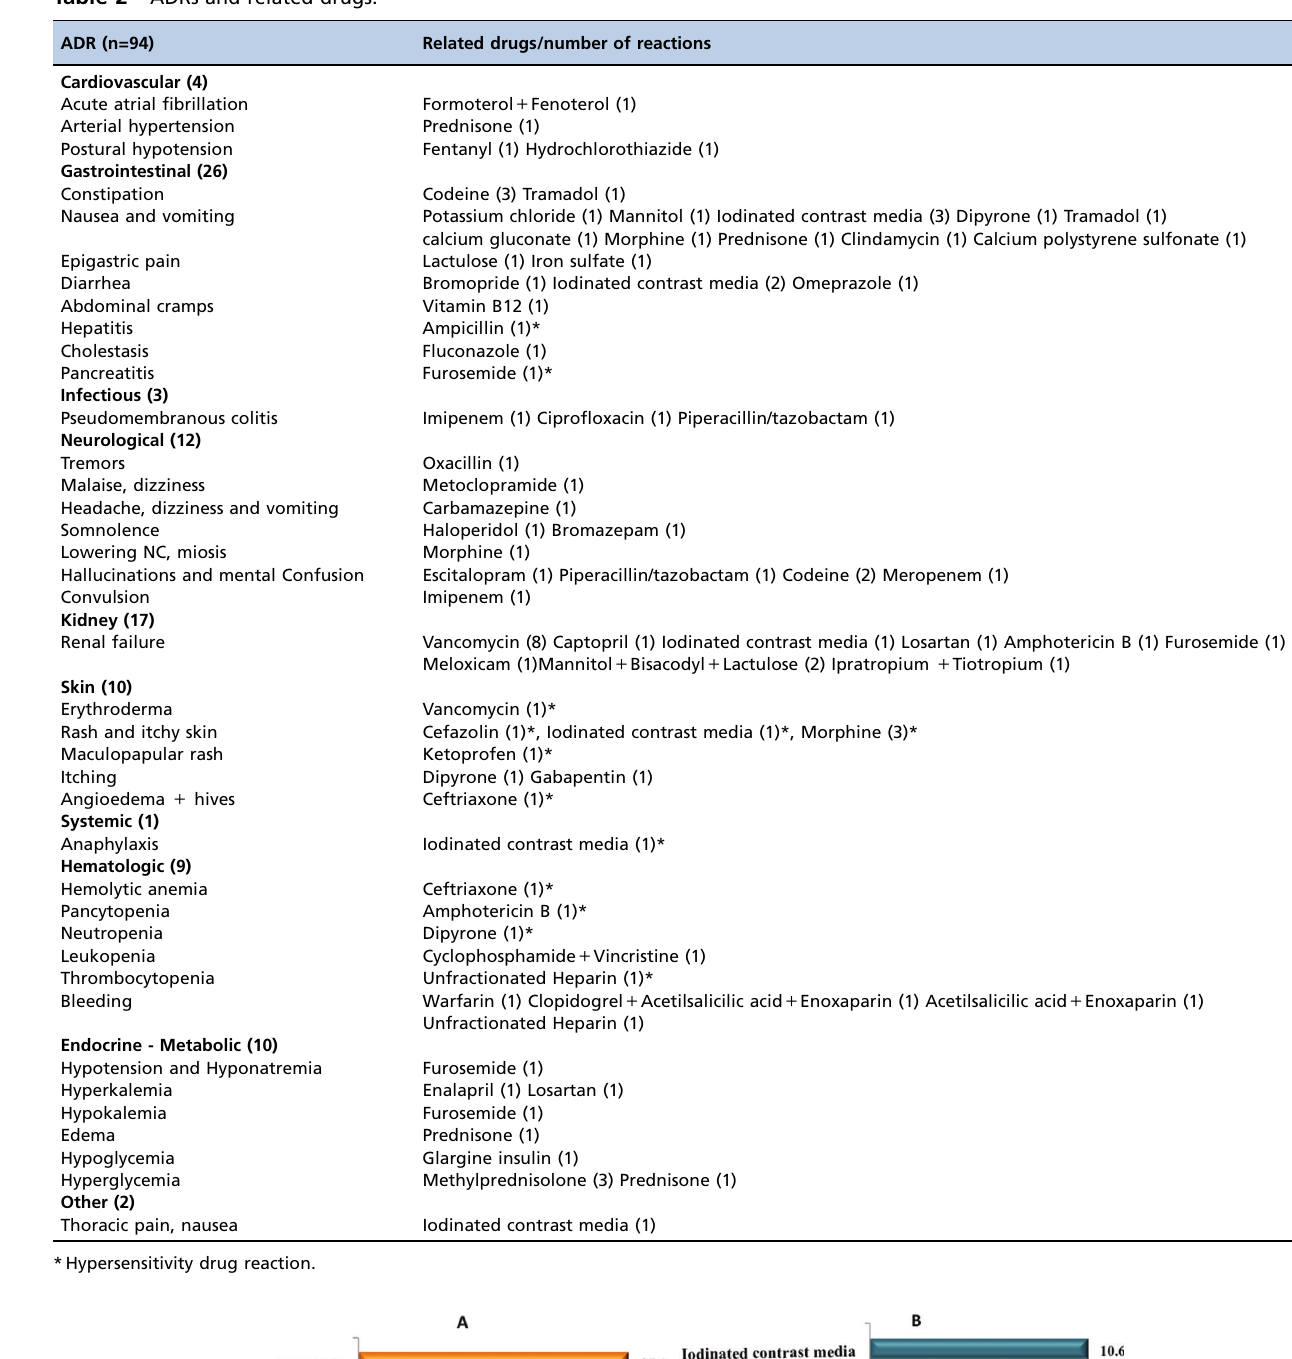
Table 2 - ADRs and related drugs.